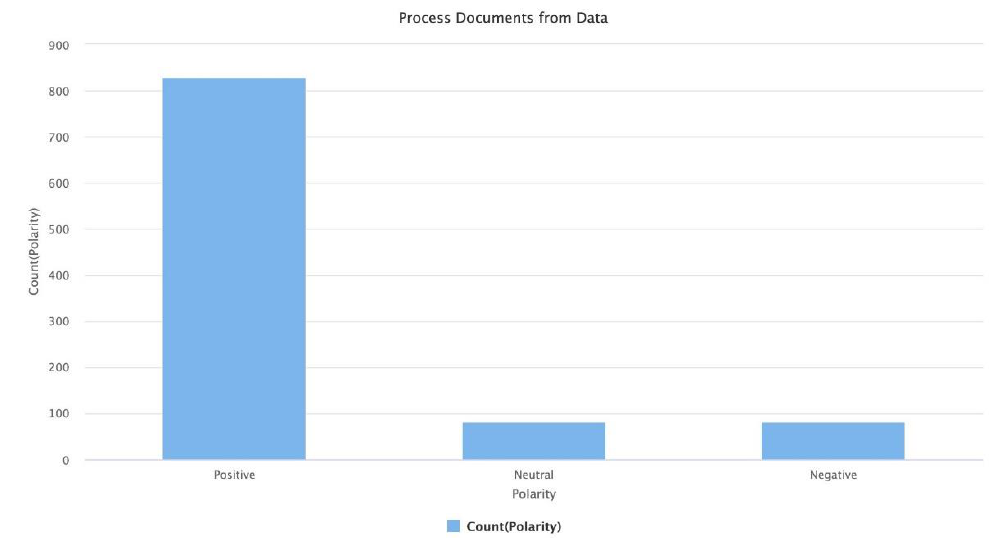
Figure 7. Processed dataset according to their classification as positive, neutral, or negative. The annotated data were utilized to train a classifier model using the Naïve Bayes classification algorithm. After training and testing, the results showed that the model attained 81.77% accuracy. The confusion matrix, which included the true positive, neutral, and negatives and the number of predicted items, is shown in Table 5. Precision and recall percentages were also